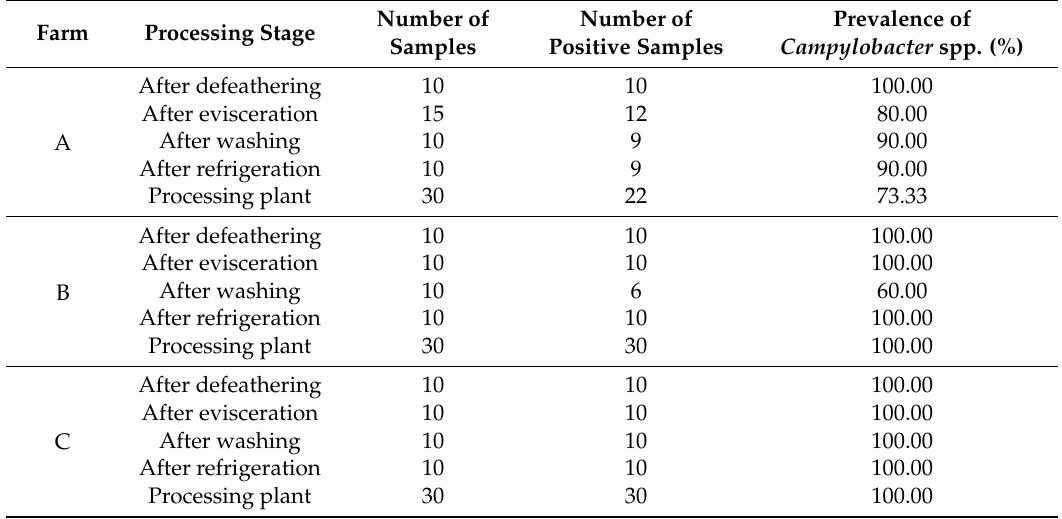
Table 2. Prevalence of Campylobacter spp. in carcasses from the 3 farms at different stages of